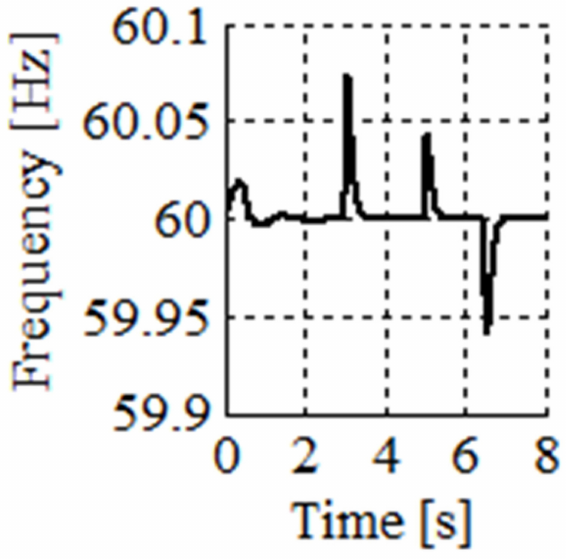
Figure 6. Frequency signal of the regulation loop with an AC-AC